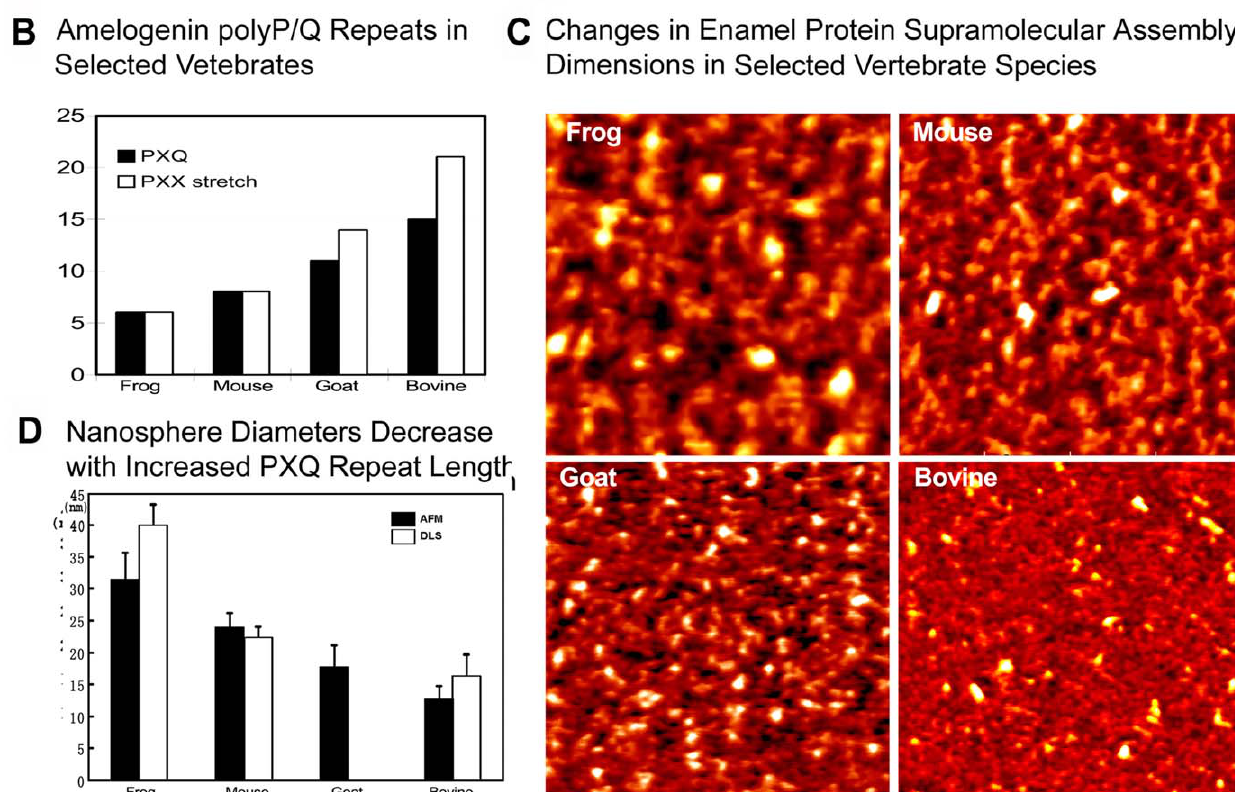
Figure 1. Polyproline repeats in the evolution of bilaterian mineralization systems. (A) Conservation and evolution of the tooth enamel protein amelogenin. Note the high conservation of PXX repeat elements among mammals (e.g., Homo, Mus), reptiles (e.g., Elaphe, Paleosuchus), and amphibians (e.g., Xenopus, Rana) (light and dark grey shaded areas). The conserved PXX majority repeat region served as a blueprint for our designer